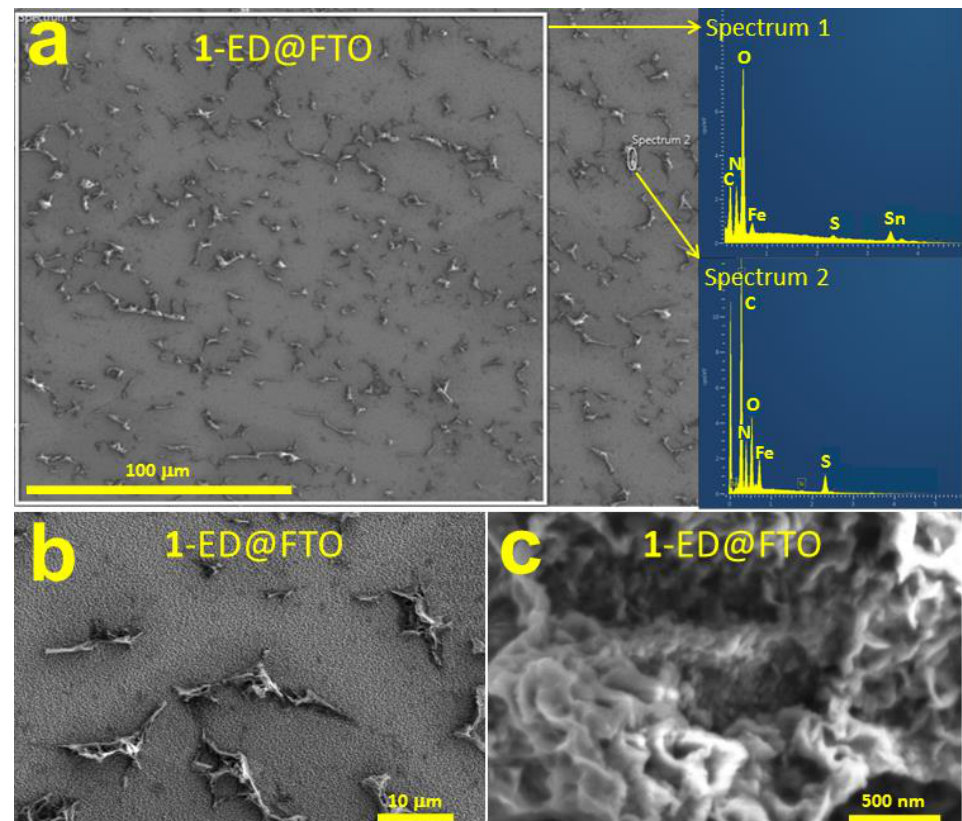
Figure 5. ( a ) SEM image at × 500 magnification of 1 -ED@FTO after 4.5 h of CA at +1.5 V vs . Ag/AgCl in 0.2 M borate buffer at pH 8.2, inset: EDX spectrum of the area in the white frame ((Spectrum 1), and from a small spot (Spectrum 2)); ( b ) SEM images at × 2000; and ( c ) at × 50,000 magnification (see Figures 1 and 3c for further information on this sample).